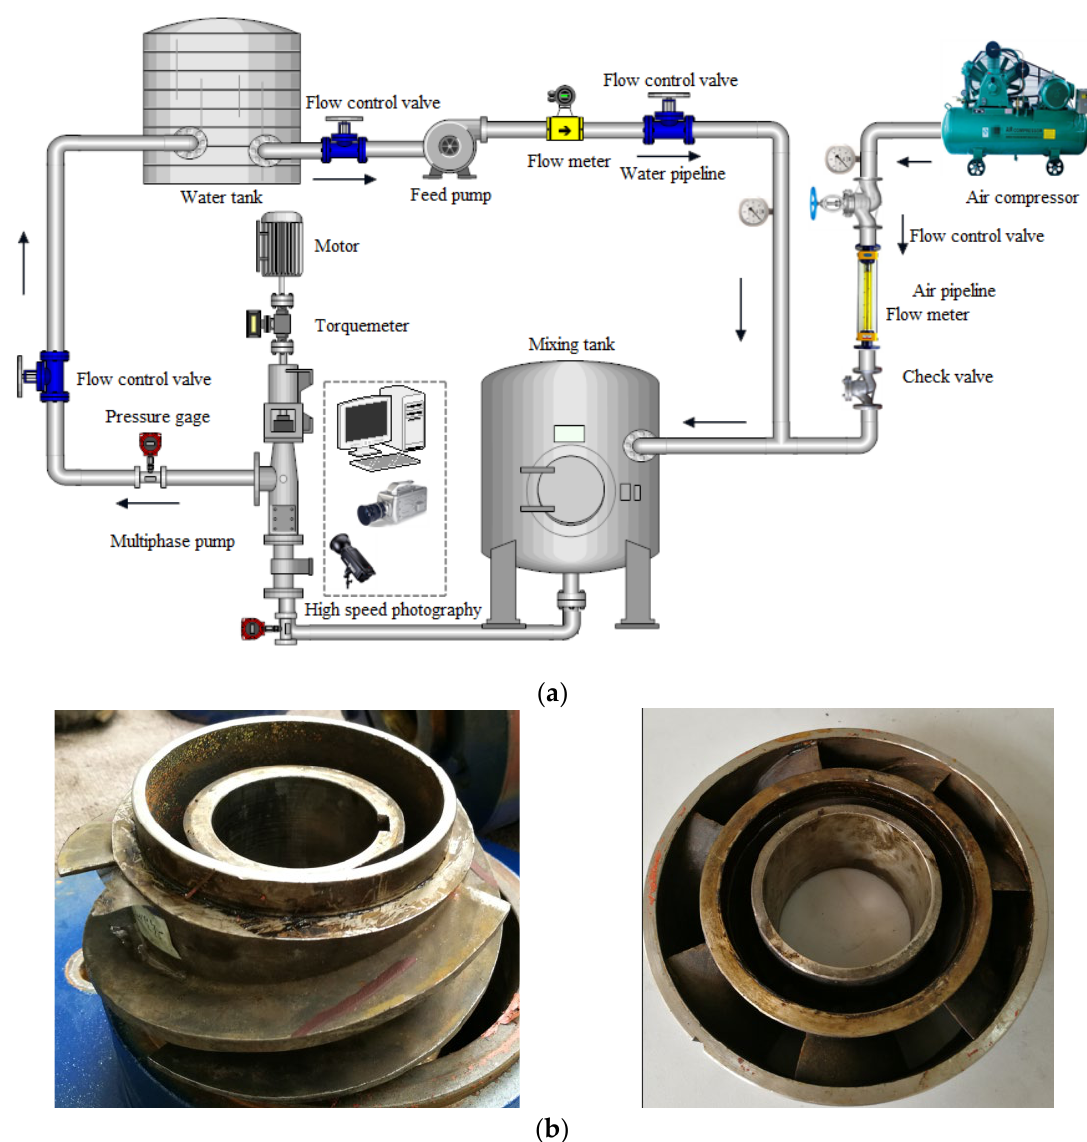
Figure 4. Experimental rig of the multiphase pump. ( a ) Schematic diagram. ( b ) Impeller and diffuser .